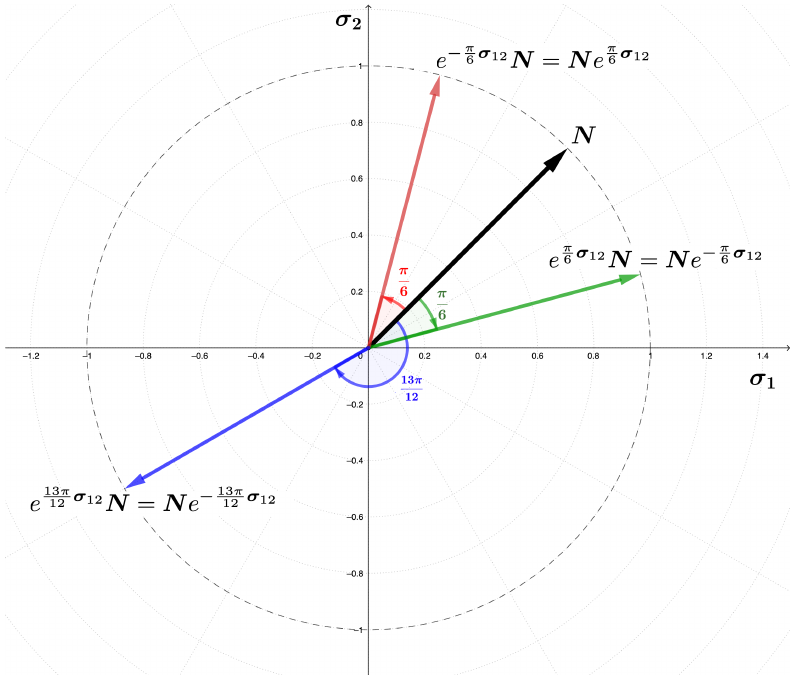
Figure 1. A vector multiplied by a rotor e ϕ σ 12 (with positive angle ϕ ) rotates in the clockwise or counter-clockwise direction depending whether the multiplication is performed by the left or by the right,